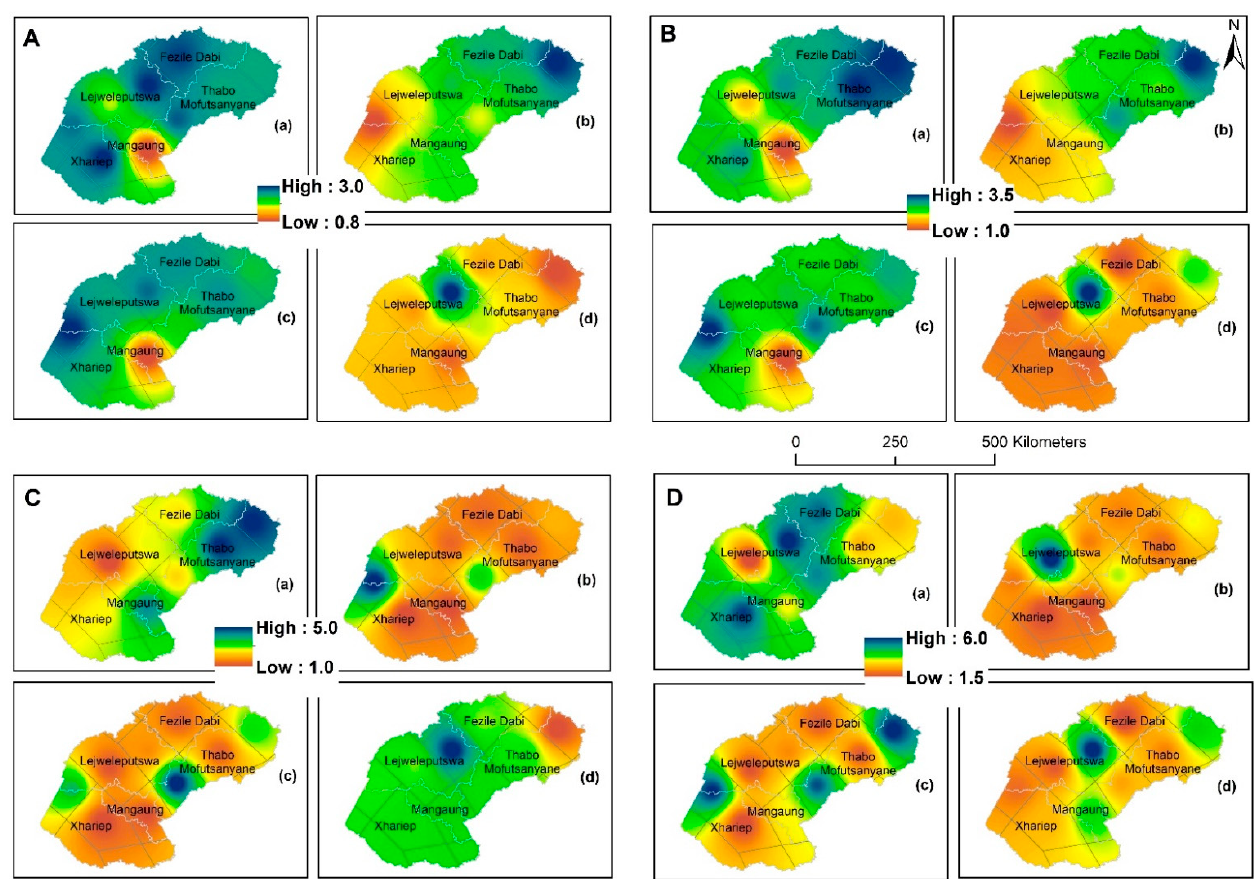
Figure 9. Spatial distribution of wet severity for the 5- (a), 10- (b), 20- (c), and (d) 50-year (d) periods over the Free State Province from 1980 to 2019: ( A ) EDI; ( B ) SPI-3; ( C ) SPI-6; ( D ) SPI-12. With the SPI-12 analysis, wet severity is expected to increase in the following dis- tricts: Lejweleputswa (Dis83), Xhariep (Dis70), and Fezile Dabi (Dis73) for the 5-year period; Lejweleputswa (Dis82) for the 10-year period; Thabo Mofutsanyane (Dis61 and -72) for the 20-year period; and Lejweleputswa (Dis83) for the 50-year period. However, less wet severity is expected in Lejweleputswa (Dis82) for the 5-year period; Thabo Mofut- sanyane (Dis60), Mangaung (Dis71), and Xhariep (Dis70) for the 10-year period; in Fezile Dabi (Dis73), Thabo Mofutsanyane (Dis60), Lejweleputswa (Dis82), and Xhariep (Dis70) for the 20-year period; and in Fezile Dabi (Dis73), Thabo Mofutsanyane (Dis60), and Lejweleputswa (Dis82) for the 50-year period. Dis60, -61, and -81 depict no change in re- turn levels for the SPI-12 analysis across the years. 3.5. Dry Return Periods Based on Extreme Frequency Analysis (EFA) in the Free State Province The return period was calculated to ascertain the likelihood of occurrence of a partic- ular magnitude of drought. Here, moderately wet, severely wet, extremely wet, moder- ately dry, severely dry, and extremely dry are considered (based on Table 1). The results for the return levels over the 4 decades are displayed in Figure 10. In all the rainfall dis- tricts, all drought indices show moderately dry conditions with varying return periods; EDI ranging from 1 to 2 years (Table 2 and Figure 10A), for SPI-3 and SPI-6 the moderately dry return period is 1 year (Table 2 and Figure 10B,C), and the SPI-12 return period is 1.1 years (Table 2 and Figure 10D). This indicates a moderately dry climate across the study site. According to the EDI and SPI-12 values, severe dry conditions are observed across